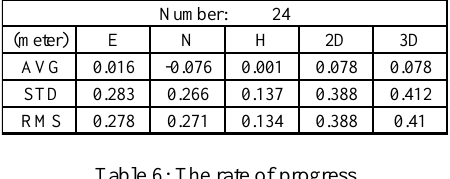
Table 5: The error of POI with control point feedback